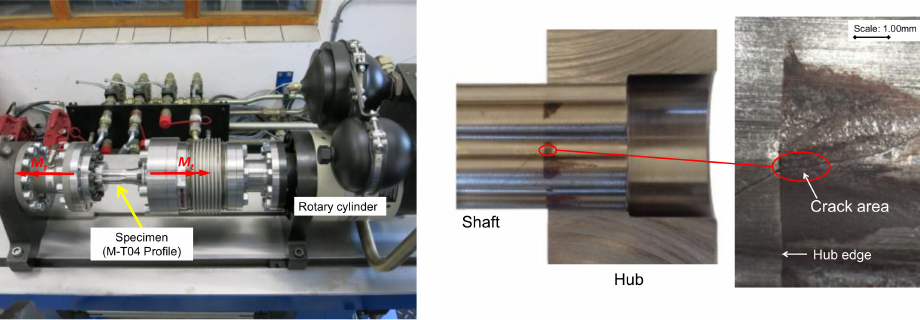
Figure 4. Testbench for the torsional load ( left ) and the cracking due to torsional loading ( right )